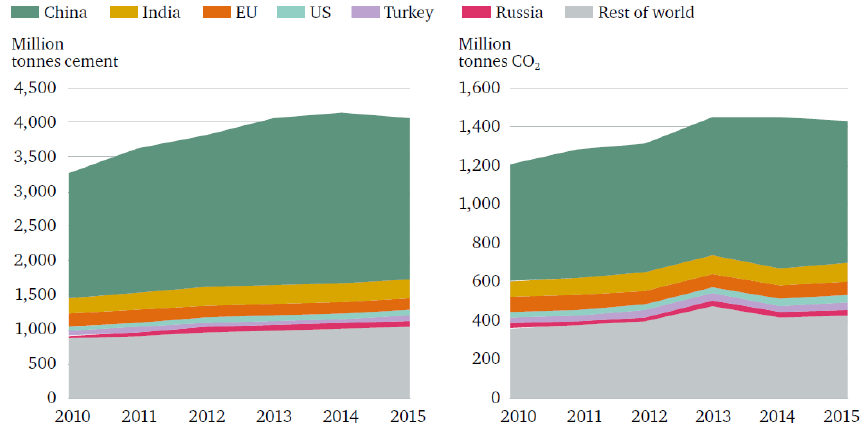
Figure 1. Cement production and cement-related CO 2 emissions from 2010 to 2015 [6].